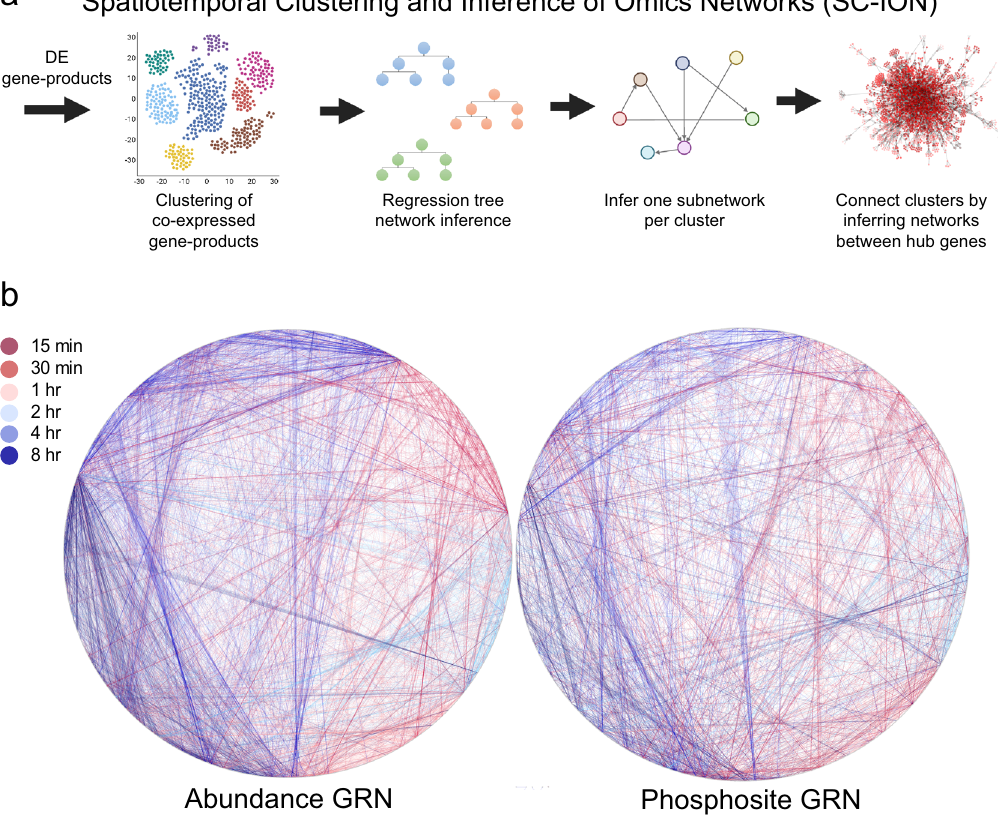
Fig. 2 Timepoint-speci fi c, integrative omics networks of BR response. a SC-ION pipeline. b Timepoint-speci fi c networks using TF abundance (left) or TF phosphosite intensity (right). Edge color represents the time point that regulation is predicted to occur. Nodes represent individual genes. The nodes are arranged in a circular layout relative to timing — genes differentially expressed at the earliest time point (15 min) are placed at the top of the circle, and time increases as one moves clockwise through the